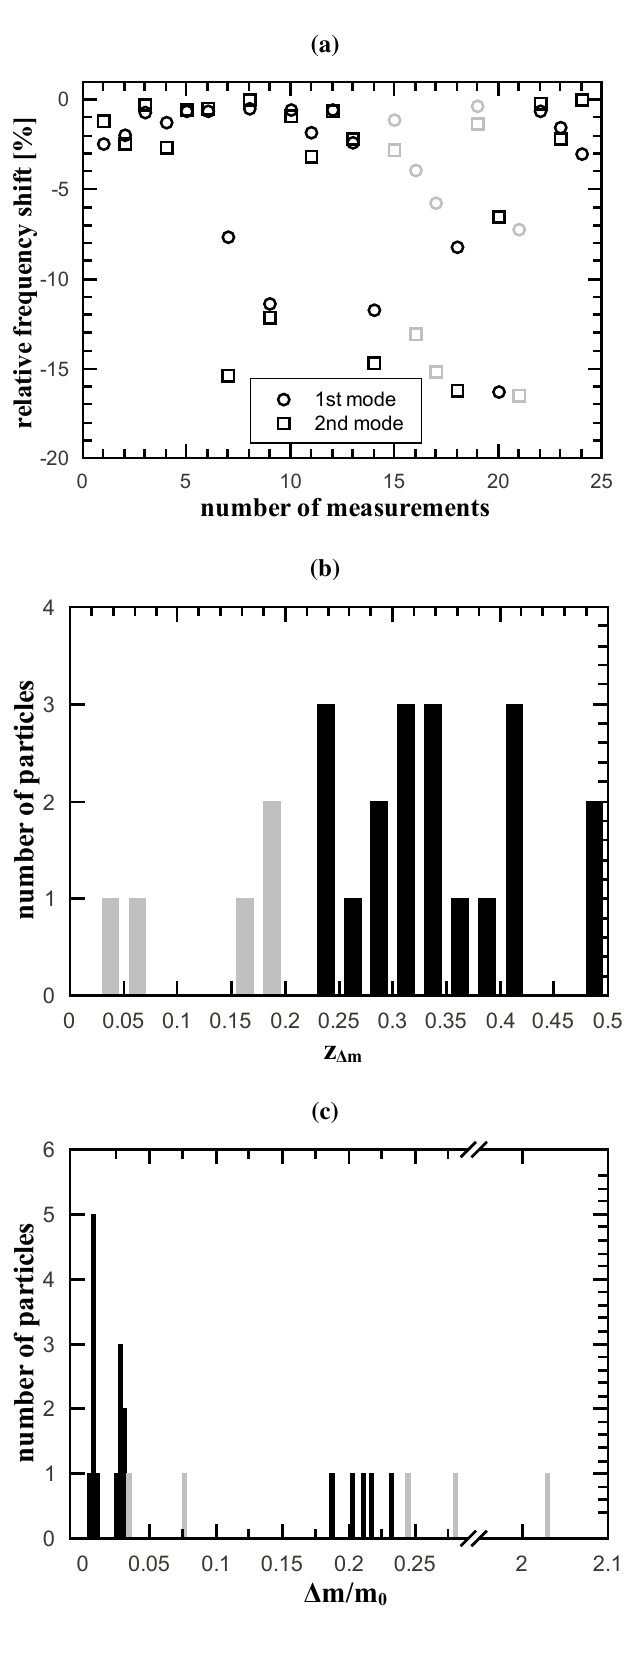
Figure 2. (a) Measured relative frequency shifts of the first and second bending mode. Histograms of number of particles (b) versus particle positions Equation(7) for L = 1 and (c) versus mass ratio Equation(8) for the three different types of micro